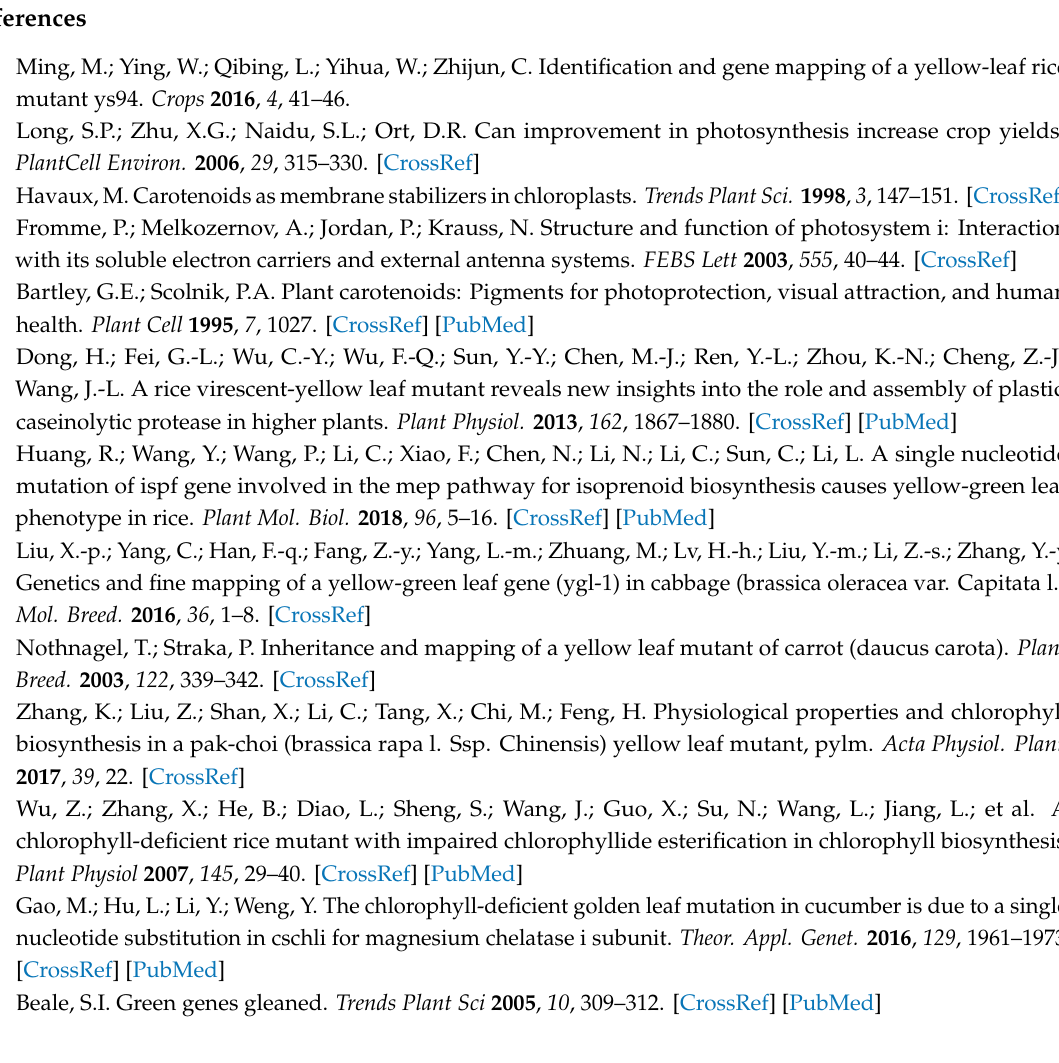
Figure S1. Real-time PCR expression analysis of four candidate LOX genes between ygl1 and 1402. Numbers 1, 2, and 3 indicates three individual biological repeats. Figure S2. Multiple alignments in deduced amino acid of four candidate LOX genes. Figure S3. Phylogenetic analysis of four candidate LOX genes. An unrooted neighbor-joining phylogenetic tree was constructed from 102 LOX proteins from 17 plant species. A bootstrap test was set to 1000 replicates to validate tree classification confidence. The bootstrap values of the confidence levels are shown as percentages at branch nodes. The four candidate LOX genes are highlighted in circles. Figure S4. Heat map of four candidate LOX genes in various tissues. The RNA-seq expression data of di ff erent tissues were used to construct tissue expression patterns of LOX genes. The four candidate LOX genes are highlighted in red boxes. Figure S5. Chromosome distribution and duplication events of LOX genes in cucumber. Chromosomal mapping was based on the physical position (Mb) in seven cucumber chromosomes. Chromosome number is indicated at the top of each bar. Positions of the cucumber LOX genes in the chromosomes were obtained from Cucurbit Genomics Database (CuGenDB: http: // cucurbitgenomics.org / ). Black blocks indicate the centromere positions in chromosomes. Scale represents 10 Mb chromosomal distance. Table S1. Primer sequences used for qPCR and gene cloning. File S1. Candidate genes and annotation in the region of chromosome 4 with an ∆ SNP-index of approximately